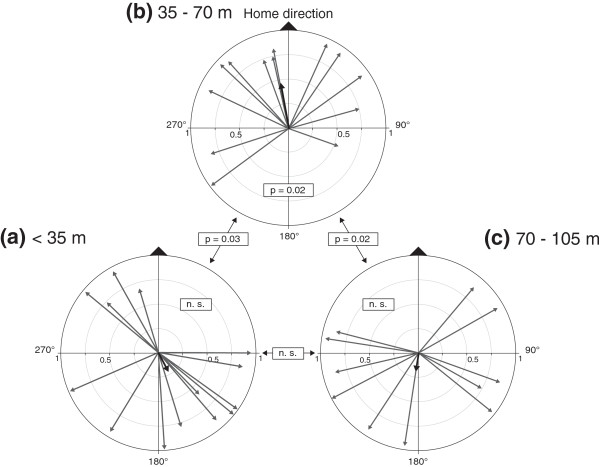
Arena orientation. Circular vector plots representing initial orientation over one meter of territorial individuals translocated from close-range, < 35 m (a), mid-range, 35 – 70 m (b), or far-range, 70 – 105 m (c). Each vector represents an individual. Vector length represents the path straightness in the arena. Vector direction represents the bearing from the arena center to the crossing point of a one-meter radius circle. Reported significance levels were obtained by second order Hotelling’s circlular test for unimodal distribution and by a Hotelling’s two-sample test for the comparisons between distributions.